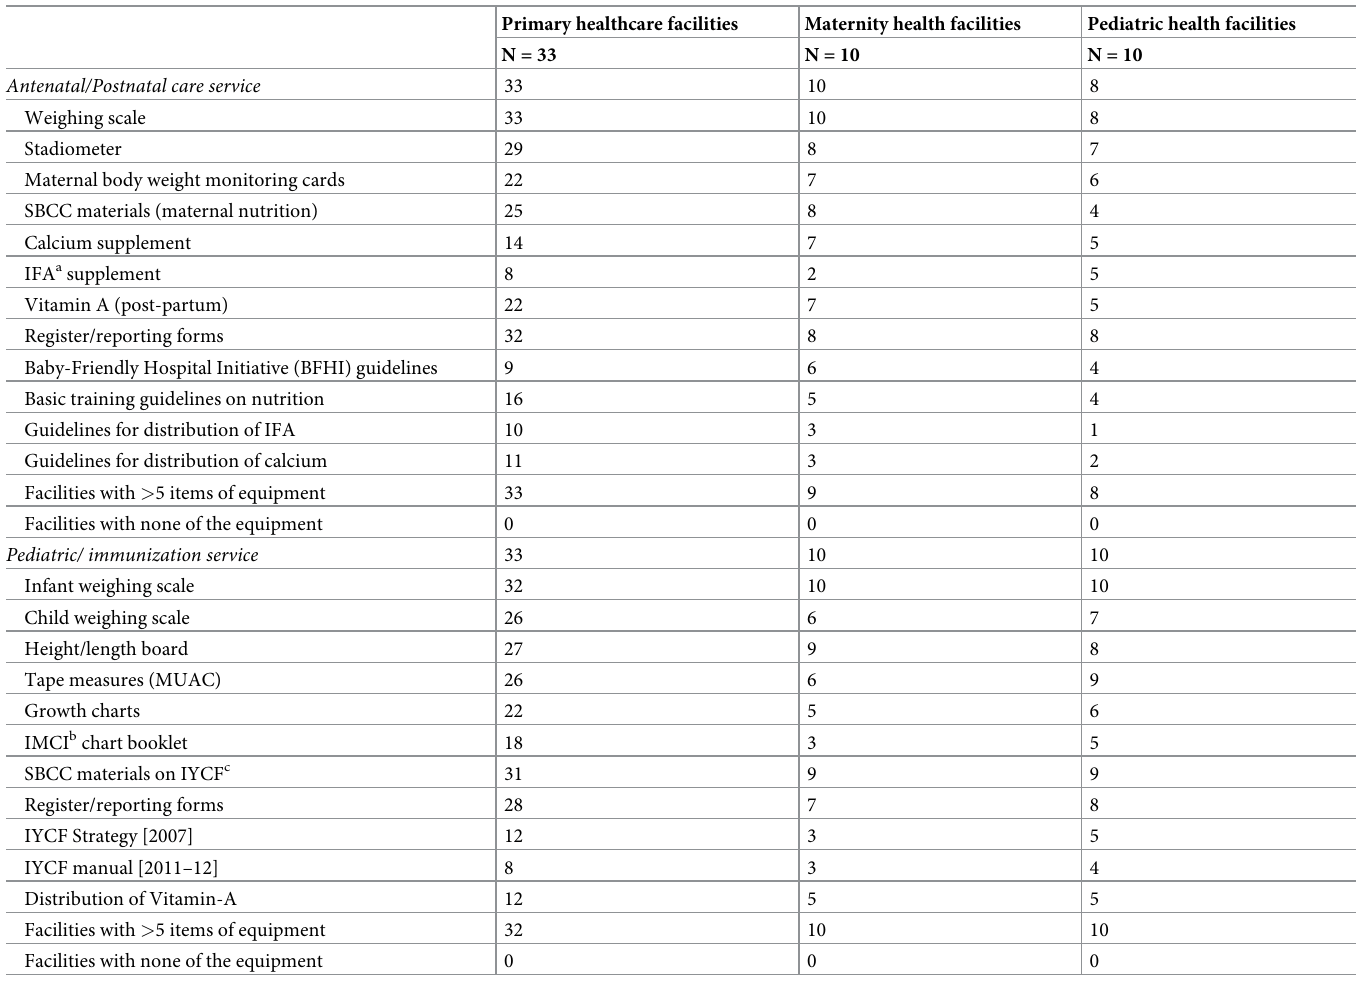
Table 3. Availability of equipment, supplements, guidelines and